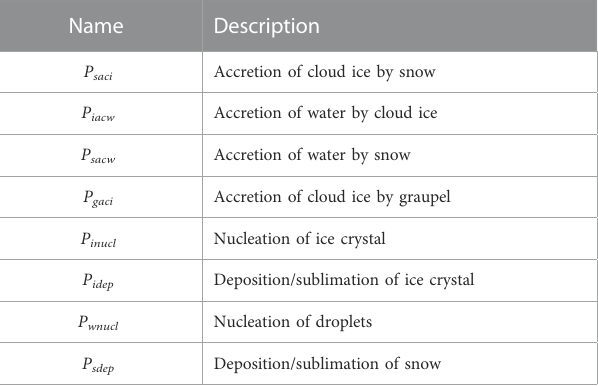
TABLE A1 Description of the main microphysical processes in WDM6 scheme.